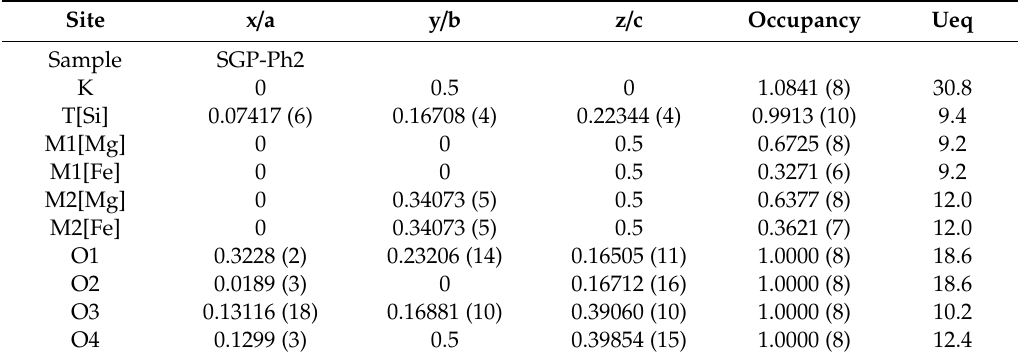
Table 6. Crystallographic coordinates and equivalent displacement parameters ( × 10 3 Å 2 ). Square brackets indicate cations used for occupancy refinement.